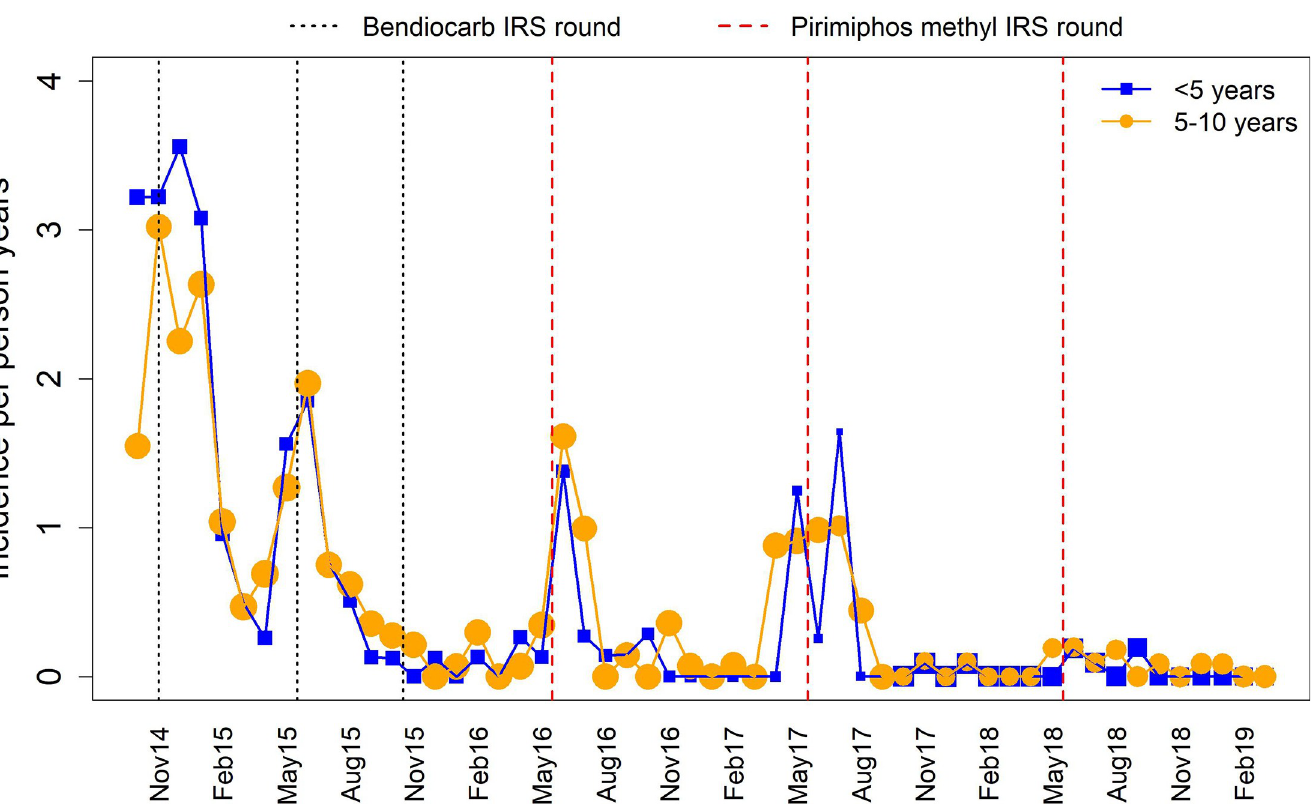
Fig 1. Incidence of malaria per person-years among children between October 2014 (just before the first IRS round) and March 2019 following 6 rounds of IRS at a site of medium transmission in Uganda. The vertical lines indicate time points at which the rounds of bendiocarb (dotted-black lines) and pirimiphos methyl (dashed-red lines) were applied, by age group. The size of the points corresponds to the number of children at risk.